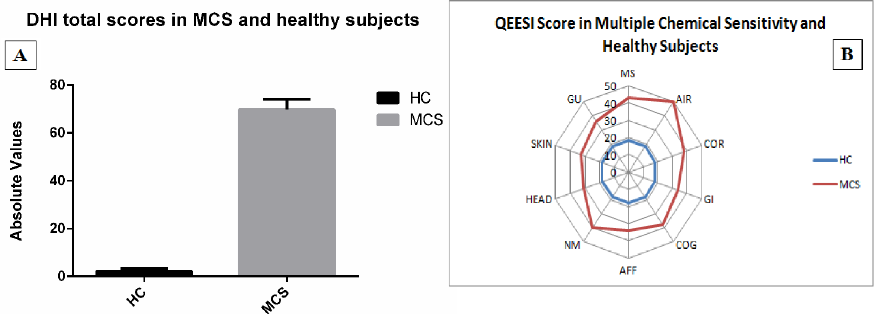
Figure 1. In ( A ) histograms highlighting dizziness handicap inventory (DHI) total scores in Multiple Chemical Sensitivity (MCS) and healthy subjects (HC); In ( B ) star diagram showing MCS and HC quick environment exposure sensitivity inventory (QEESI) sub-items results in head-related (HEAD), cognitive-related (COG), affective-related (AFF), neuromuscular-related (NM), musculoskeletal-related (MS), skin-related (SKIN), genitourinary-related (GU), gastrointestinal-related (GI), heart/chest-related (COR), airway or mucous membrane-related (AIR/MM) symptoms.